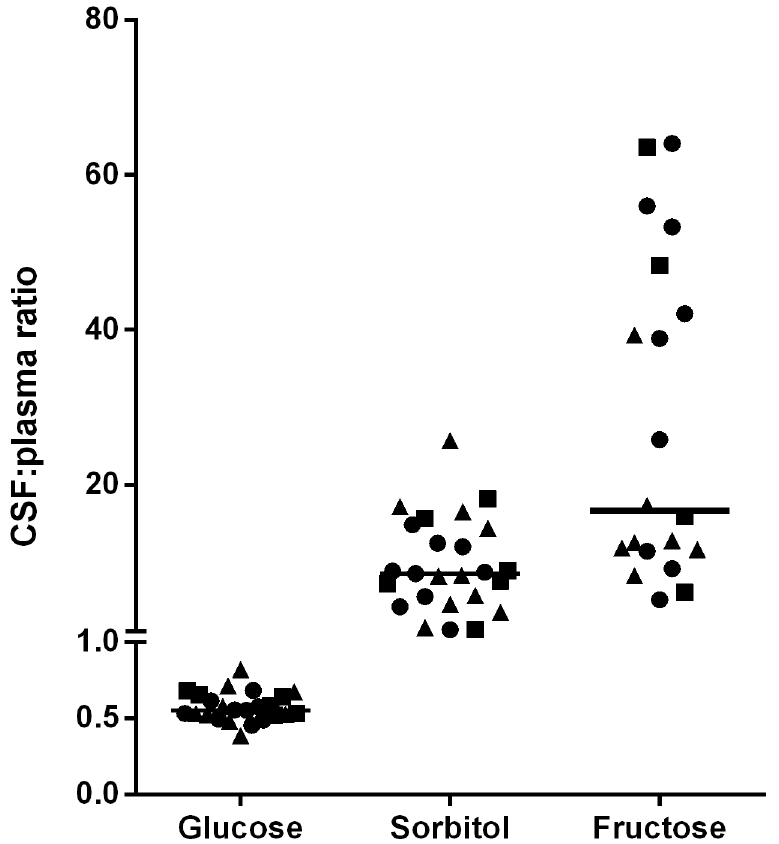
Fig 1. CSF to plasma ratios of glucose, sorbitol, and fructose. Line represents median ratio. Circle = DM; Square = Lean; Triangle = Overweight/Obese